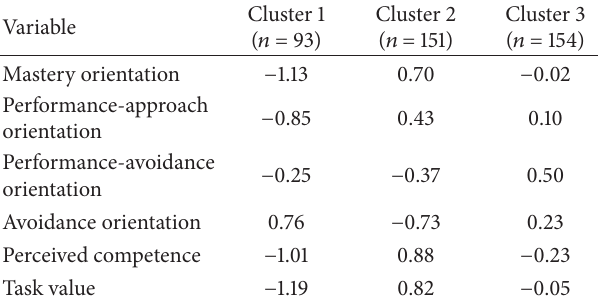
Table 3: Cluster means for final three-cluster solution ( 𝑁 =